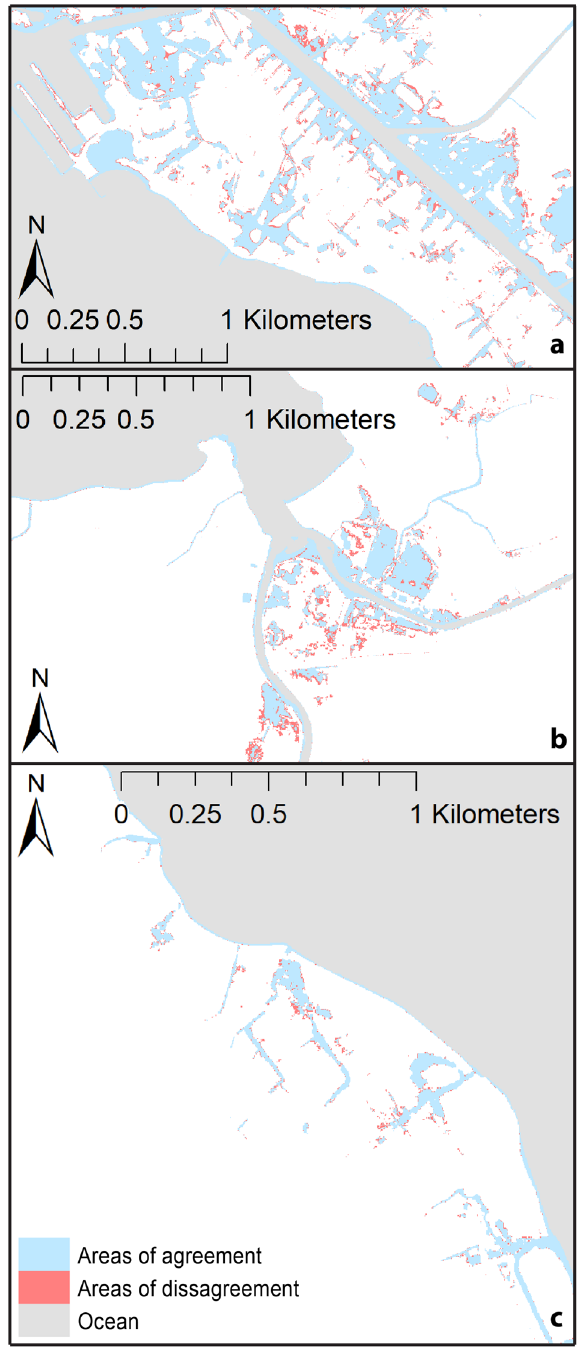
Figure 3. Maps depicting flooding considering the NOAA Intermediate scenario by 2100 23 for the Honolulu tide gauge (1.19 m) as projected using TCARI and ORS methods; red—area of difference, blue—area of agreement. ( a ) Waikīkī; ( b ) Hale ʻ iwa; ( c ) Hau ʻ ula. (Maps generated with ArcGIS Desktop 10.8.2; http:// www. esri.